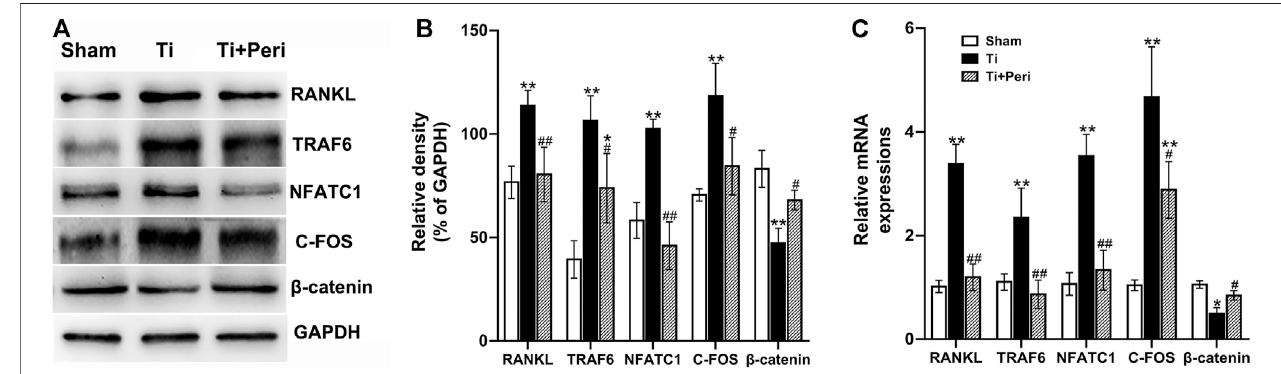
FIGURE 7 | Inhibition of ACE repressed Ti-particle-induced osteolysis by suppressing the RANKL signaling pathway and activating the Wnt/ β -catenin signaling pathway. Relative levels of RANKL, TRAF6, NFATC1, C-FOS, and β -catenin in mouse calvarial tissues to the control GAPDH expression were determined by Western blotandRT-qPCR.Dataarerepresentative imagesorexpressedasthemean ± SDofeachgroupfromthreeseparate experiments ( n (cid:1) 3per group). (A,B) Westernblot analyses. (C) RT-qPCR analyses. * p < 0.05 vs. the sham group; ** p < 0.01 vs. the sham group; # p < 0.05 vs. the Ti group; ## p < 0.01 vs. the Ti